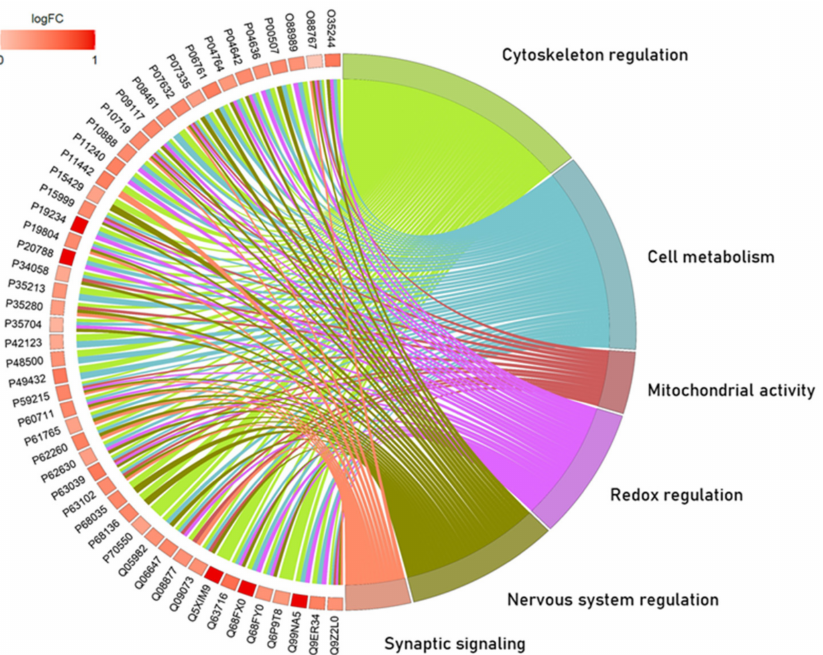
Figure 2. Over-representation analysis (Circos plot) presents the protein-protein interactions between the AlCl 3 and control groups in the hippocampus and the biological processes involved according to Gene Ontology. The altered regulation is expressed according to the colors. Red represents superexpression, and light red represents